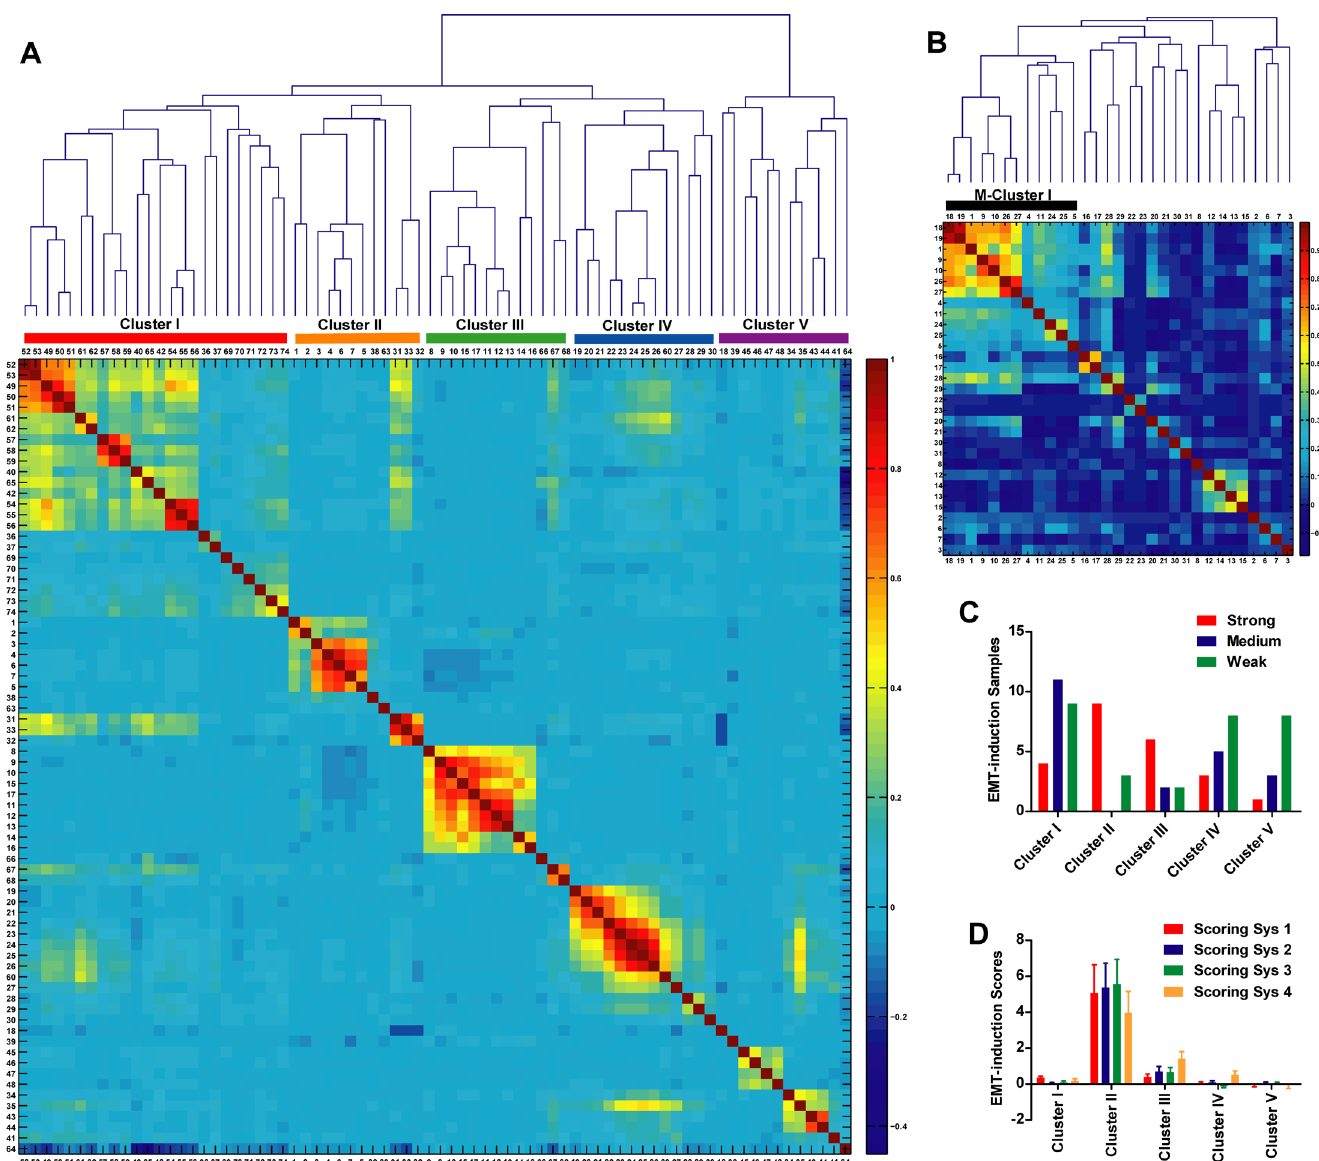
Fig 3. Clustering EMT-induction samples. (A-B) 74 human and 31 mouse EMT-induction samples were grouped into clusters by the expression profiles. The correlations among pairs of samples were shown in (A) for human and (B) for mouse. (C-D) 74 human EMT-induction samples were grouped into five clusters. The numbers of samples with strong EMT, medium EMT or weak EMT were listed in (C). The average scores of samples in these five clusters were listed in